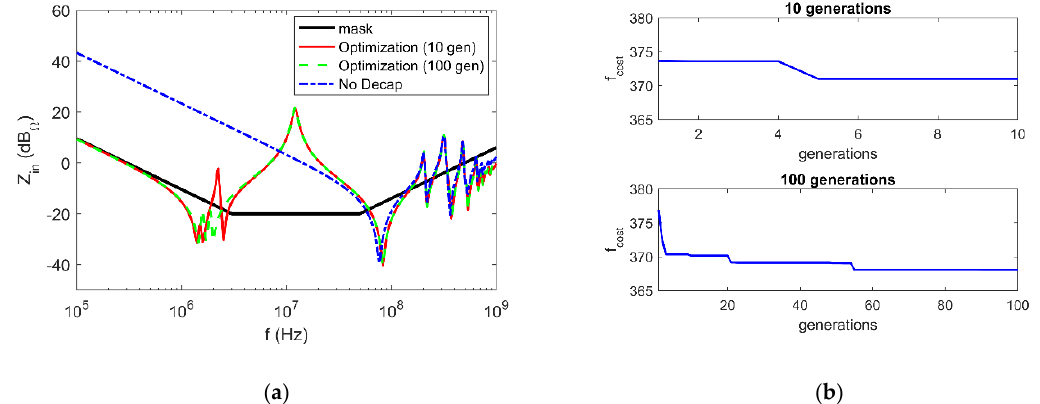
Figure 7. ( a ) Result of the optimization in EZpp after 10 generations (solid red line) and 100 generations (dotted–dashed green line) compared with the mask and the case without decaps. ( b ) Cost function f cost as function of the number of generations when max gen = 10 and max gen = 100.